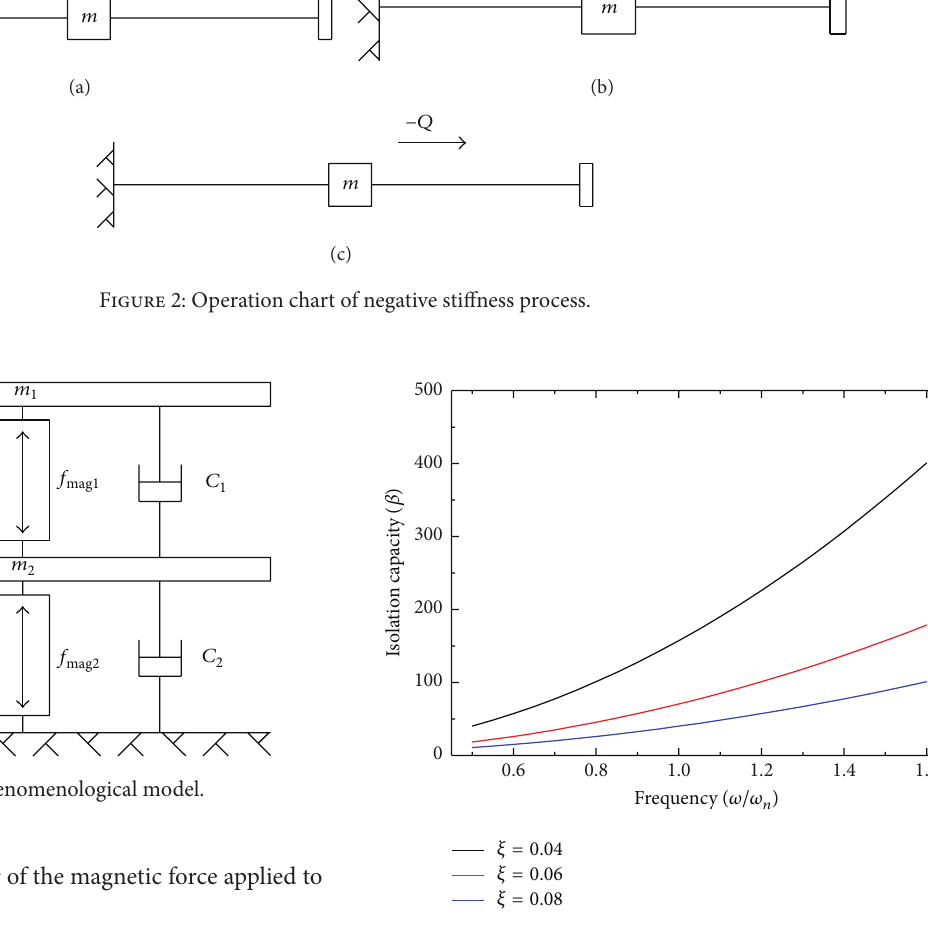
Figure 4: The vibration isolation capacity of the